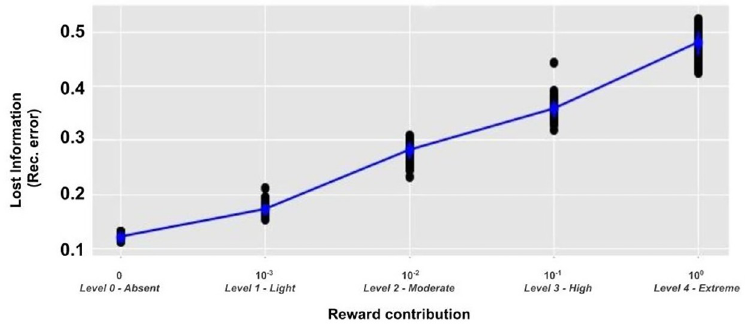
Fig 10. Information loss for different levels of RL. Information loss (reconstruction error at the end of the training) of models with different levels of RL.